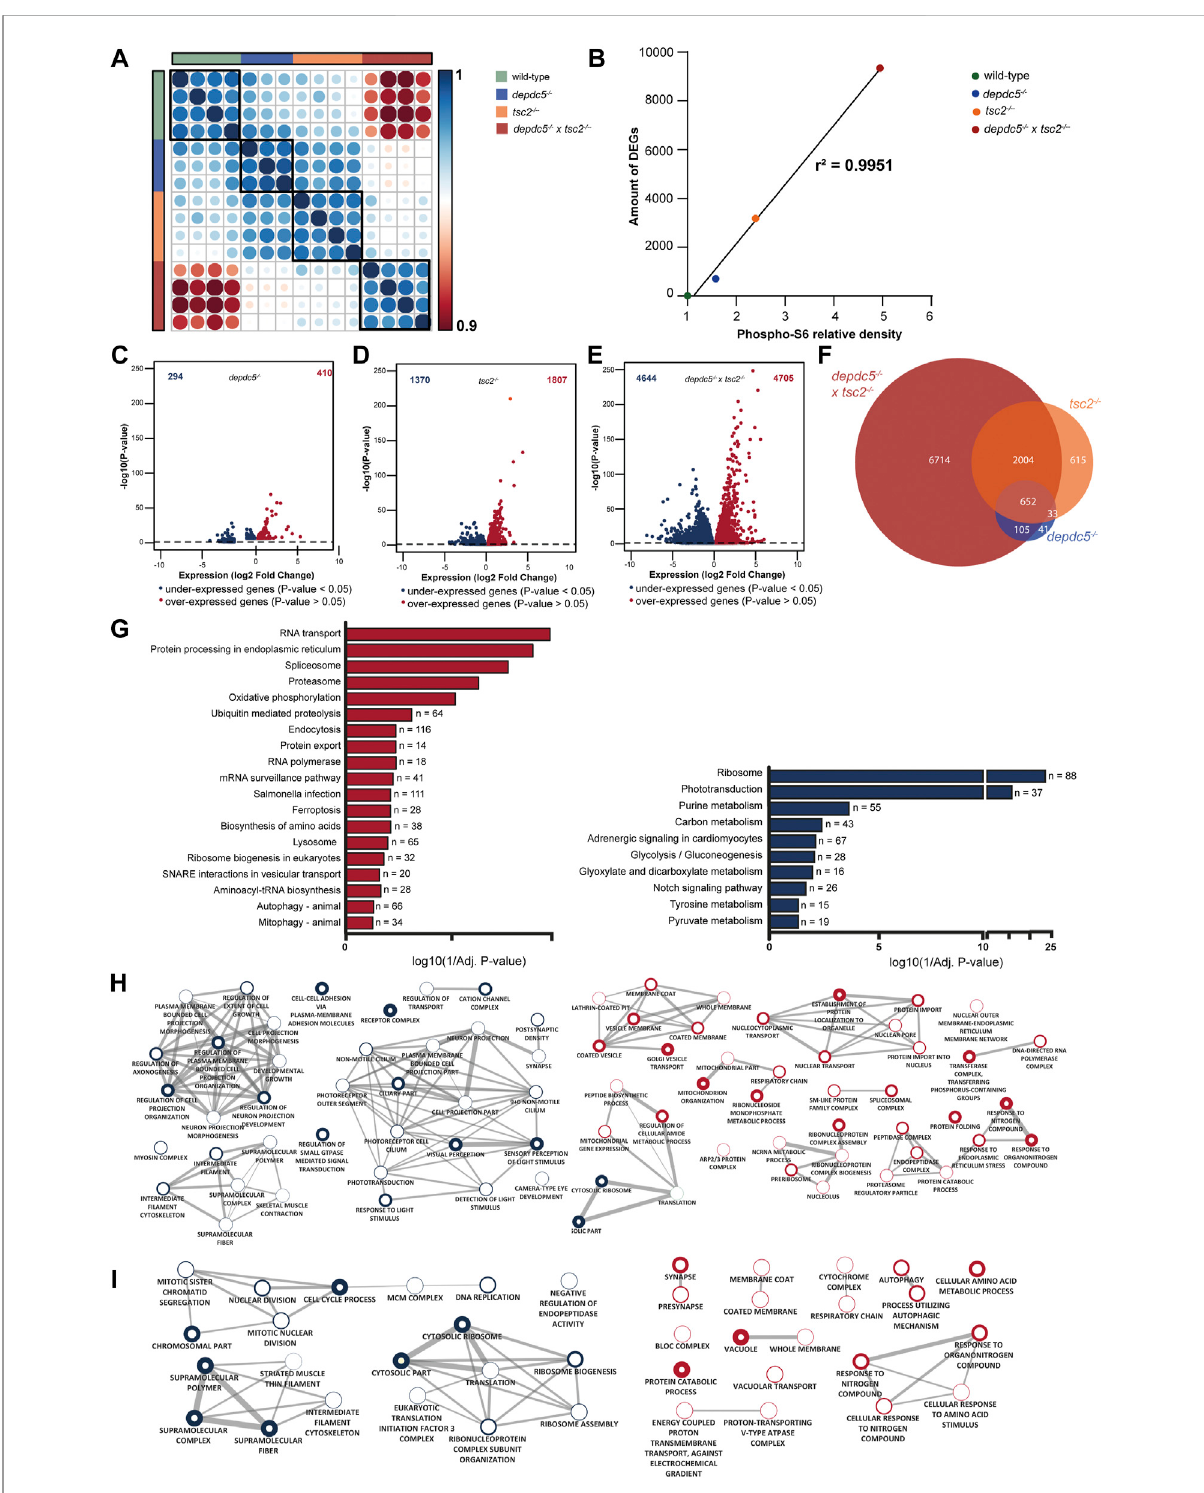
FIGURE 4 Comparison of the transcriptome pro fi les of depdc5, tsc2 and double homozygous zebra fi sh larvae. (A) Spearman ’ s rank correlation matrix of the RNA-Seq data showing separate clustering of wild-types, depdc5 − / − , tsc2 − / − , and double homozygous larval samples. Areas of the circles show absolute values of corresponding correlation coef fi cients. Different genotypes are indicated in distinct color codes. Scale bar indicates the strength of the correlation. (B) Linear and signi fi cant relationship between the levels of pS6 protein and the amount of DEGs. (C) Volcano plot showing